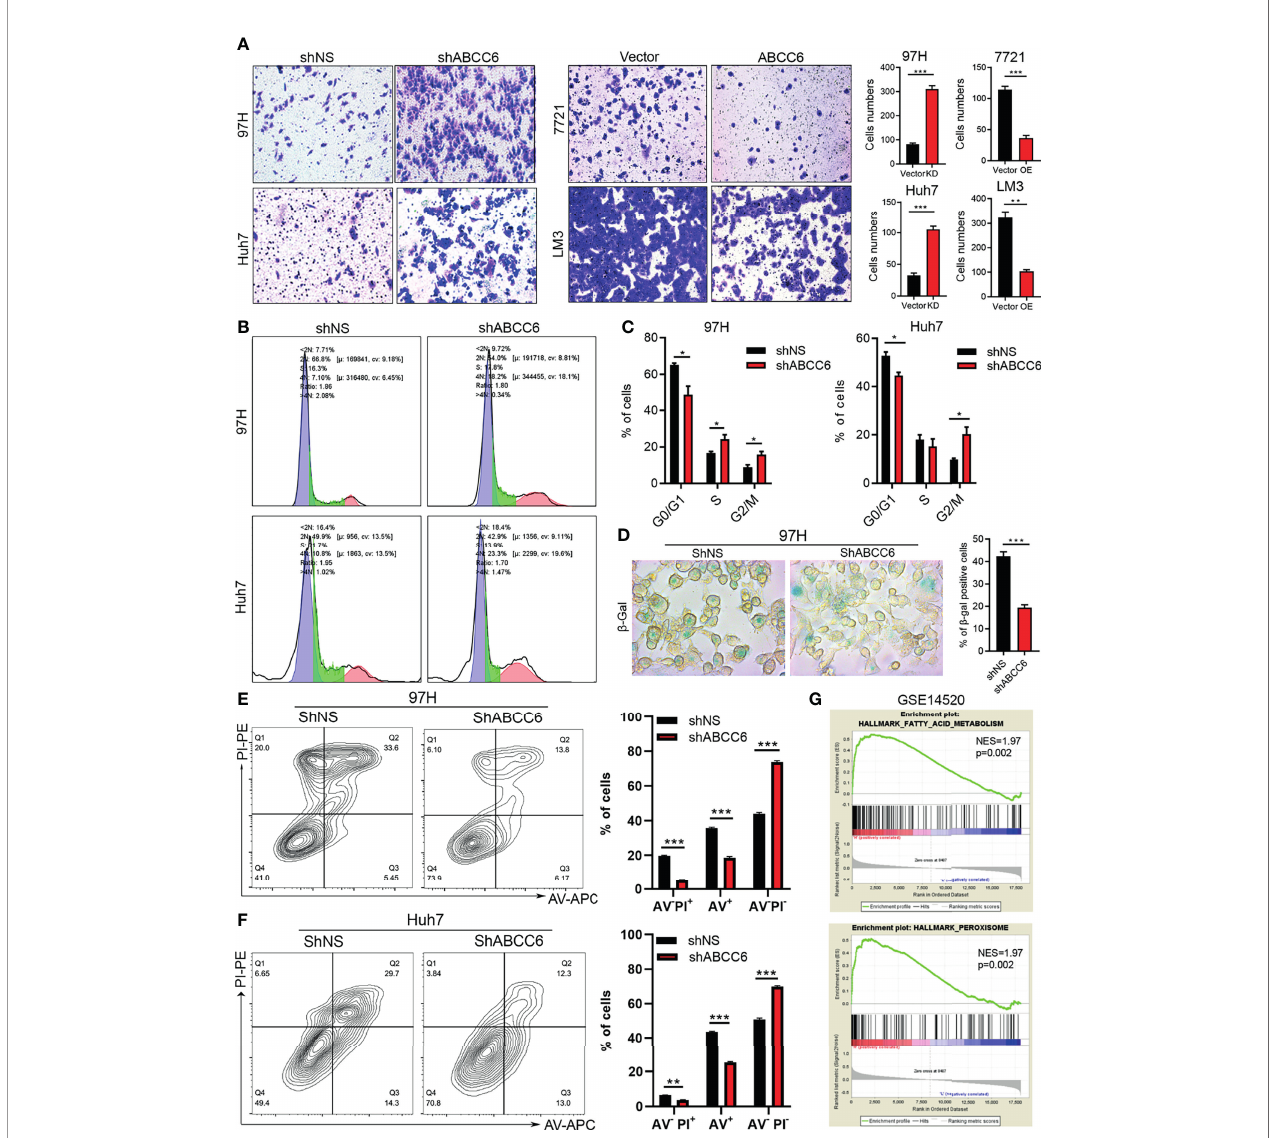
FIGURE 5 | ABCC6 affect HCC cell lines migration, cell cycle arrest and apoptosis. (A) Transwell assay showing the effect of ABCC6 knockdown and overexpression in the migration ability of HCC cell lines. (B) The results of cell cycle analysis by fl ow cytometry in ABCC6 knockdown 97H and Huh7 cells. The blue peak and the red peak represents G0-G1, G2-M stage respectively. The middle is S stage. (C) Statistical analysis showing the effect of ABCC6 knockdown in the cell cycle of 97H and Huh7 cells. (D) b -galactosidase staining showing the senescence status of HCC cell lines after ABCC6 knockdown. (E) Flow cytometry analysis showing the effect of ABCC6 knockdown on the apoptosis of 97H cells treating with 20 m M cisplatin for 24 hours. (F) Flow cytometry analysis showing the effect of ABCC6 knockdown on the apoptosis of Huh7 cells treating with 20 m M cisplatin for 24 hours. (G) GSEA analysis showing the enrichment pathway of ABCC6 high samples in GSE14520 dataset. Error bars indicate means ± SEM. P -values were determined by two tailed t -test (A, C – F) . * P < 0.05, ** P < 0.01, *** P <